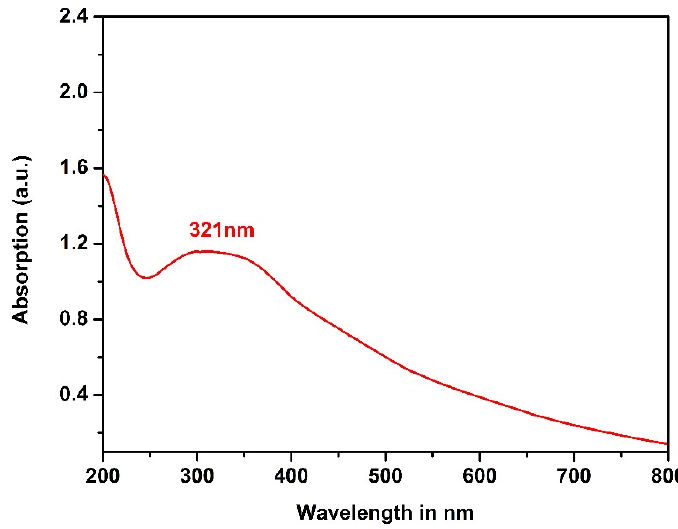
Figure 6. The UV-Visible spectra of green synthesized CuO NPs.